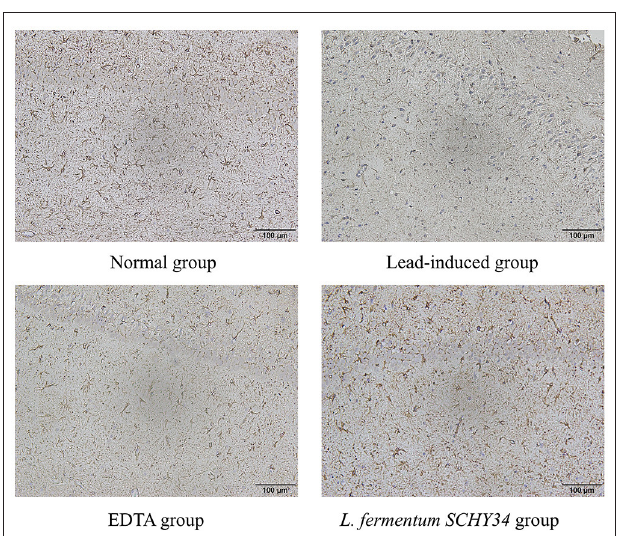
FIGURE 5 | GFAP immunoreactivity of hippocampus in SD rats.